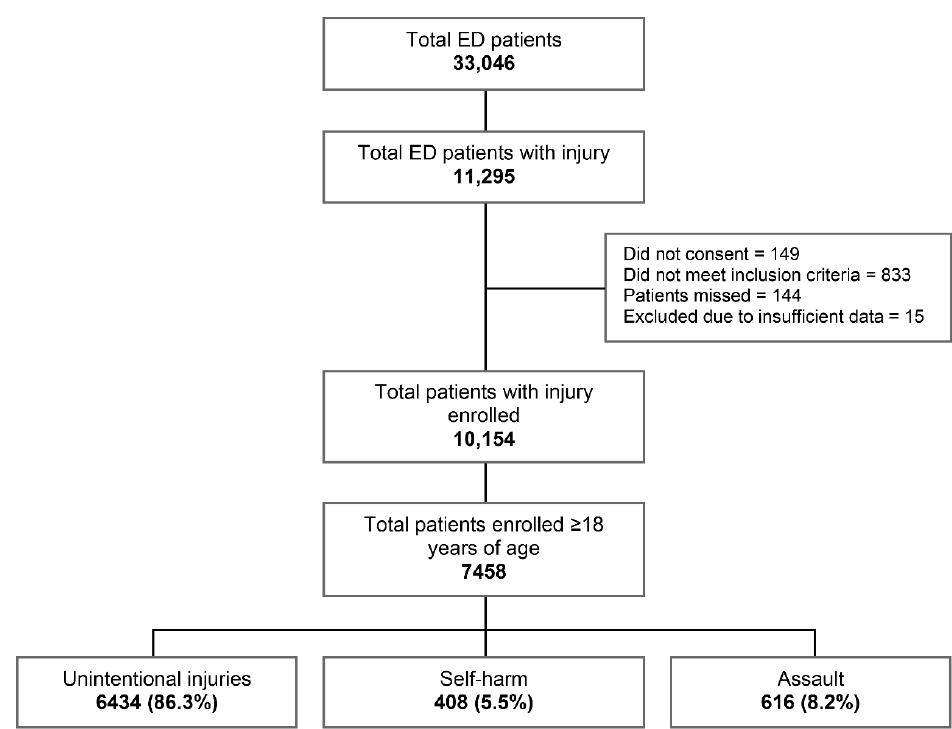
Figure 1. Patients with injuries attending the emergency departments of hospitals in the Makwanpur district, Nepal, April 2019–March 2020. Table 1. Number and rates of ED attendance with injury by age and